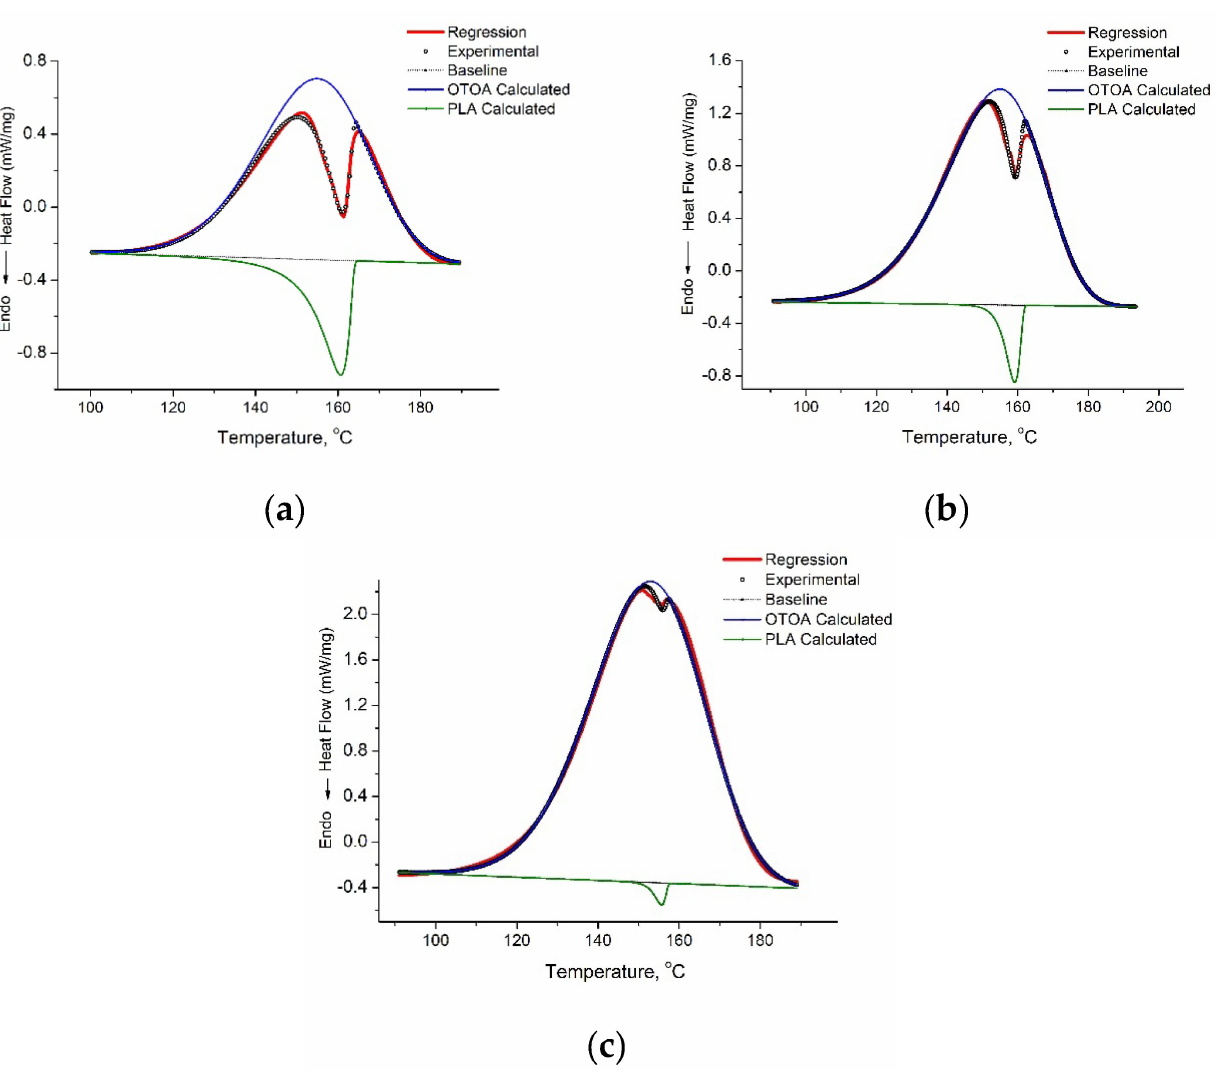
Figure 9. Deconvolution of the overlapping exo- and endothermic calorimetric peaks in the DSC thermograms for PLA + OTOA film samples with high OTOA content: ( a ) PLA +30% OTOA, ( b ) PLA +50% OTOA, ( c ) PLA +70%